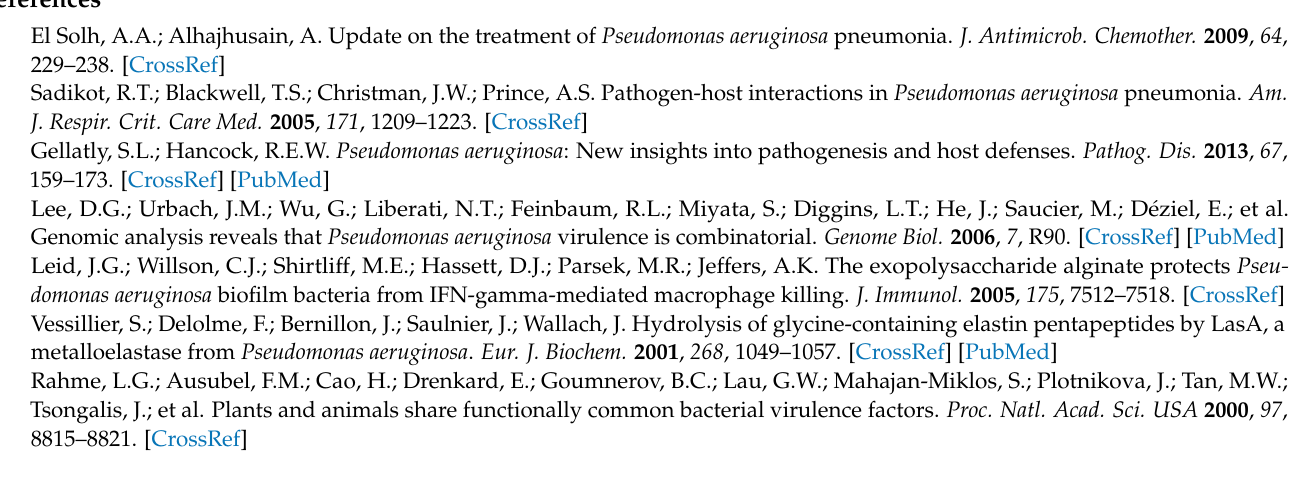
Figure S2: Procedure for collection of four different P. aeruginosa fractions, Figure S3: Characterization of the fractions of P. aeruginosa grown in constant exposure to full-spectrum light (L) and total absence of light (D) by DLS, Figure S4: Effect on A549 cell viability (%) induced by fractions of P. aeruginosa grown in constant exposure to full-spectrum light (L) and total absence of light (D), Figure S5: Contrast phase micrography of A549 cells exposed to a specific concentration (Table 1) at 48 h